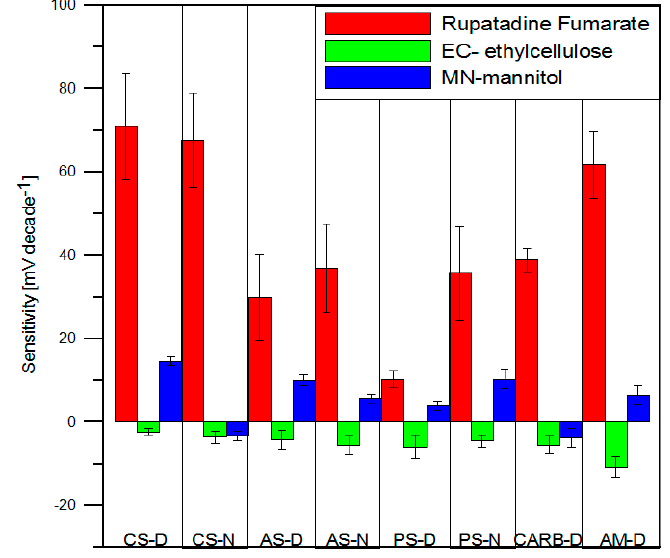
Figure 5. Sensitivity of sensors towards RUP, EC, MN.